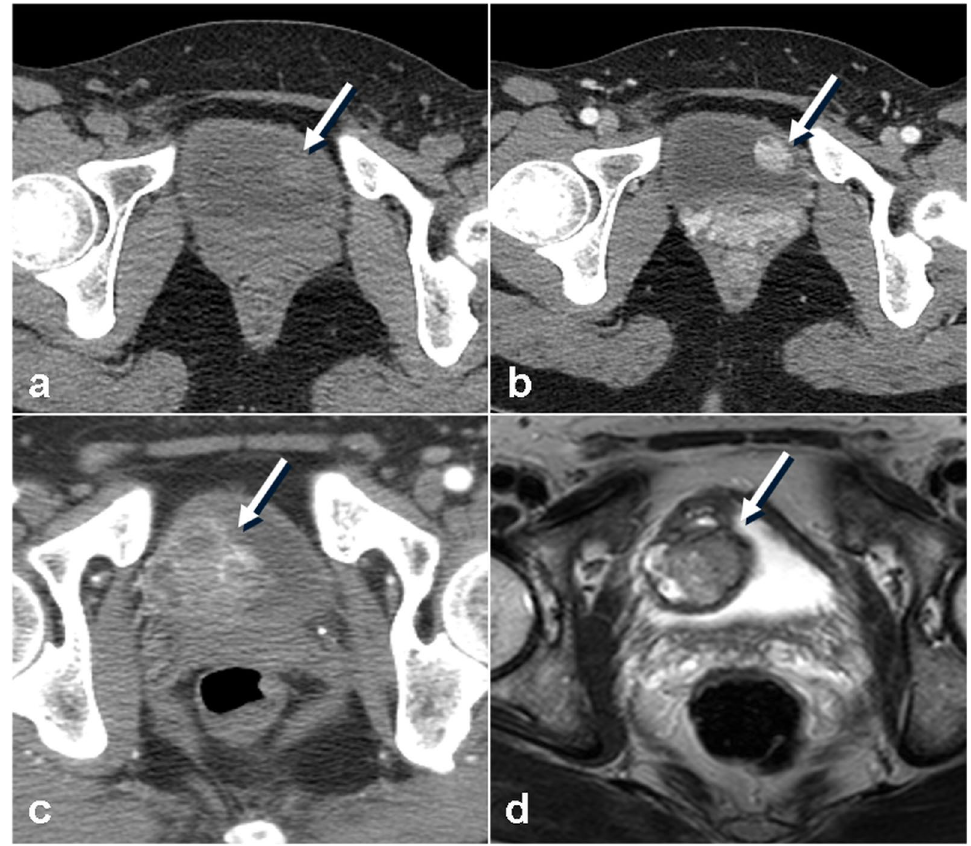
Fig. 11 Two cases of bladder paraganglioma. Axial pre‑contrast ( a ) and post‑contrast ( b ) CT images of a 38‑year‑old female woman showing a well‑circumscribed, avidly enhancing nodular lesion at the anterior wall of the bladder. c Axial contrast‑enhanced CT image of a 48‑year‑old man showing a lobulated intraluminal mass with heterogeneous early enhancement. d Axial T2‑weighted MRI showing heterogeneous high signal intensity in the mass with a peripheral hypointense rim representing the calcification